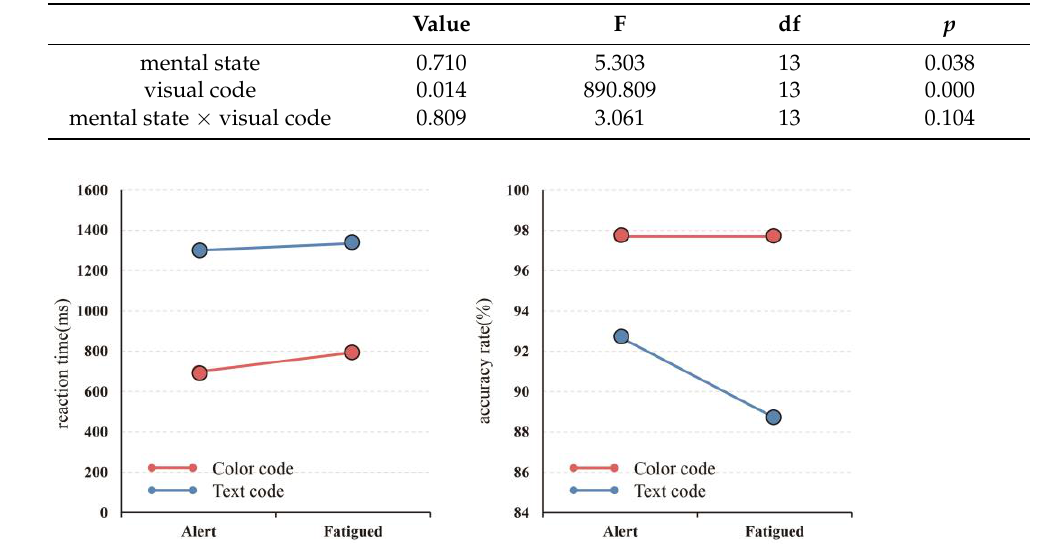
Table 4. Multivariate ANOVA results for reaction times of mental state and visual code.